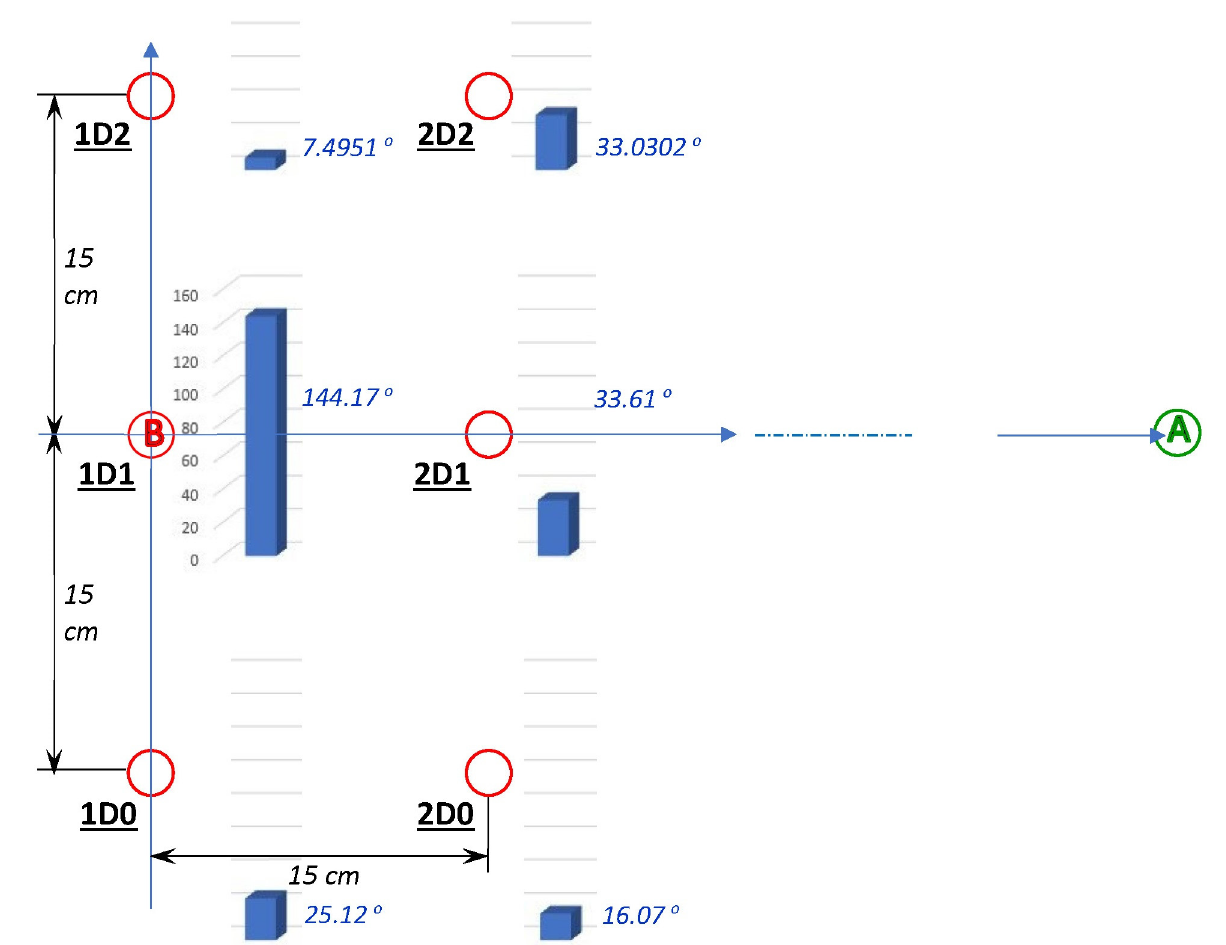
Figure 7. Alternative locations of the magnetic disrupter and corresponding effects in Location (B). (The circled A and B letters represent Locations (A) and (B), respectively.) The red circles are the locations of the magnetic disrupter labeled as XDY, where 1D1 is the standard placement at (B). The heights of the blue prisms represent the RMS value of Kalman filter estimation quaternion distance with respect to the Trio orientation estimation (in degrees) while the MARG was hovering over location (B) and Poses 6–10 were held according to the standard